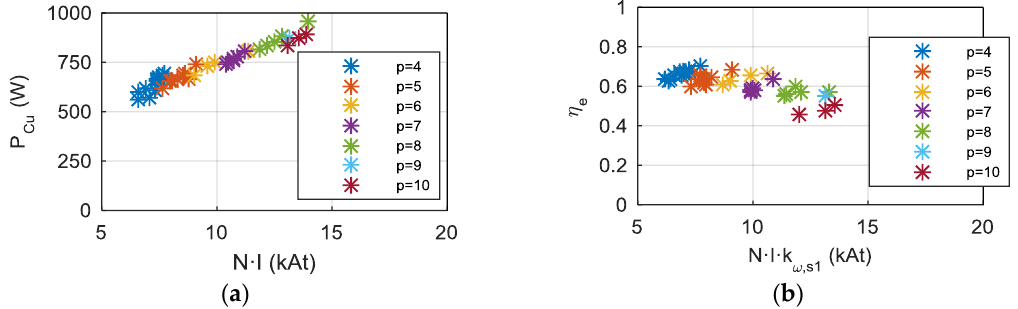
Figure 25. ( a ) Copper losses ( P Cu ) versus magnetomotive force ( N·I ) and pole pair number ( p ); ( b ) and electromagnetic efficiency ( η e ) versus magnetomotive force multiplied by the first harmonic winding factor ( N·I·k ω,s 1 ) and pole pair number ( p ); for ISDW and FSDW machines.